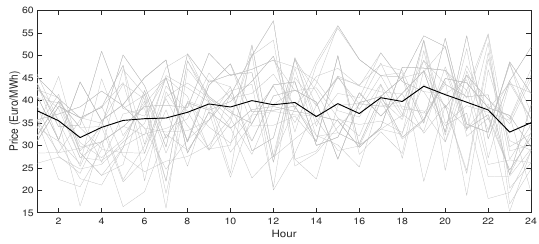
Figure 7. Scenarios and mean of the real-time market down-regulating